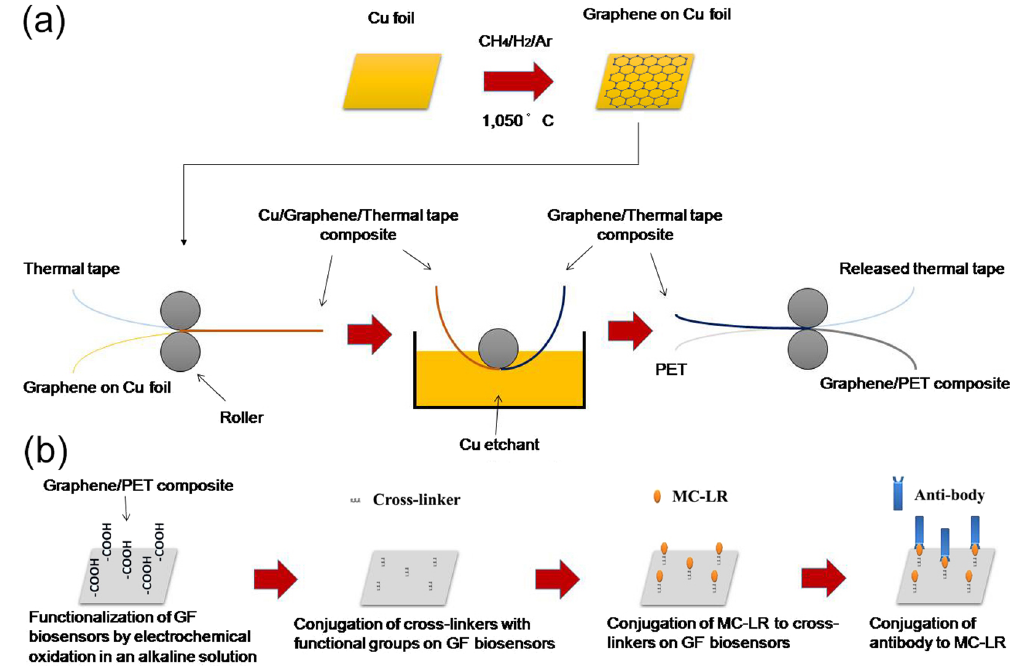
Figure 1. Schematic illustrations of GF biosensor electrode synthesis procedure ( a ) and preparation procedure ( b ) for MC-LR detection in